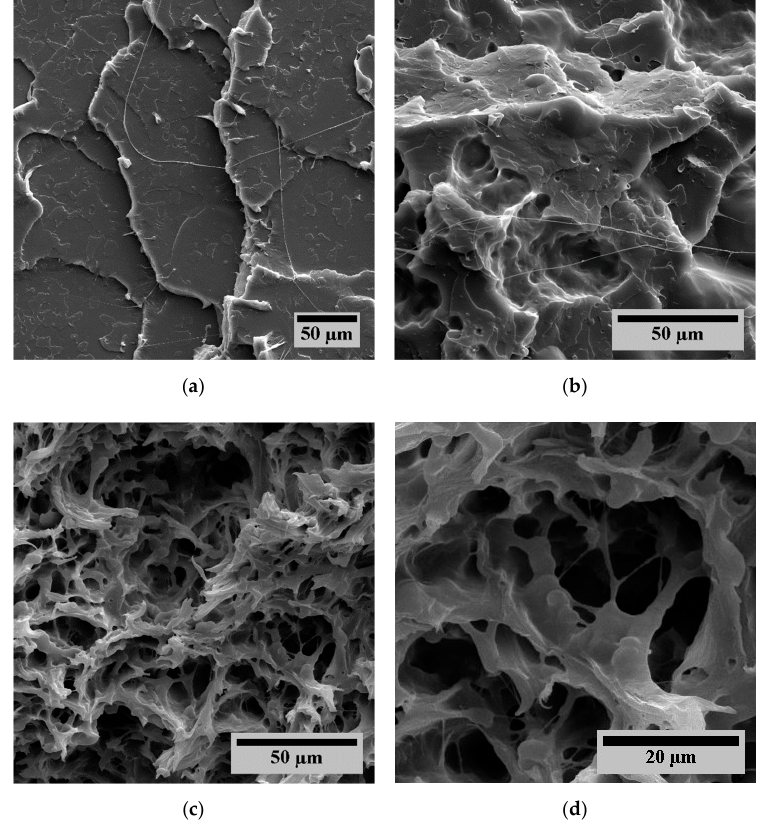
Figure 16. Fracture surfaces of tensile tests. ( a ) P100, ( b ) P80-E20, ( c ) P80-E16-S4-C5-T0.2, and ( d ) P80-E16-S4-C5-T0.2 with a higher